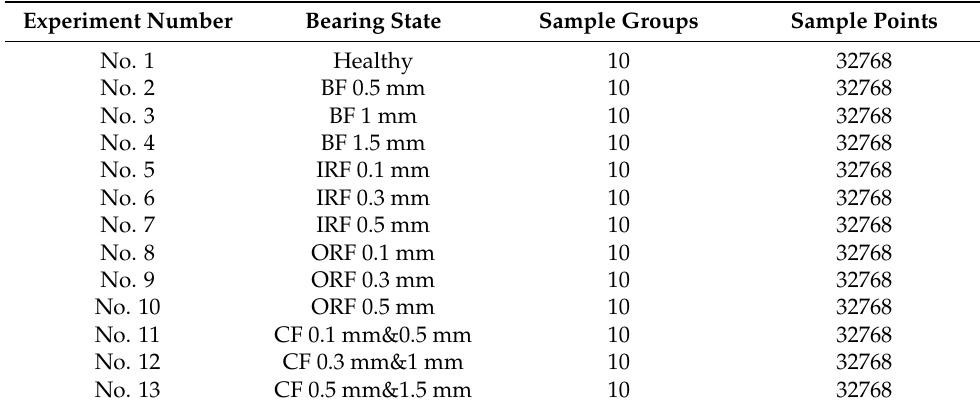
Table 7. Test parameters for 13 different fault states.